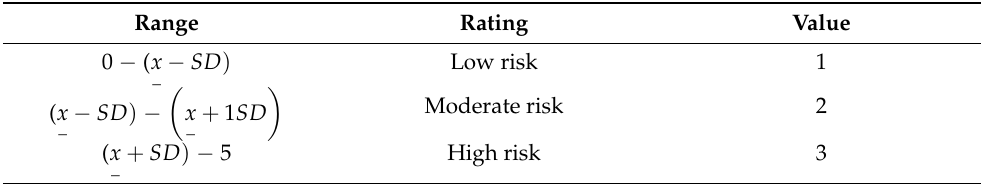
Table A13. GHG Emission Risk assigned